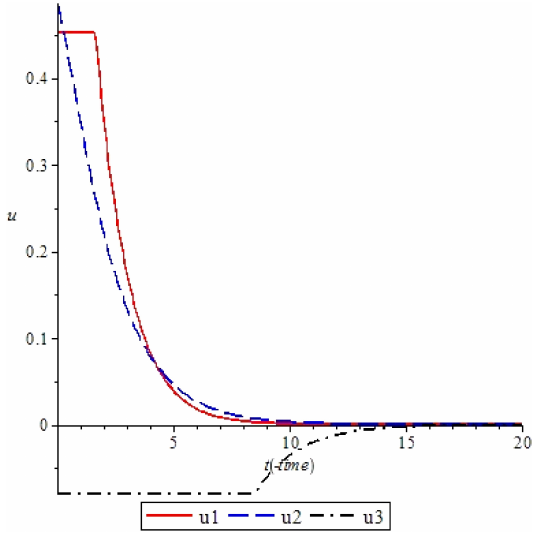
Fig. 6. Graphs of optimal controls u ð t